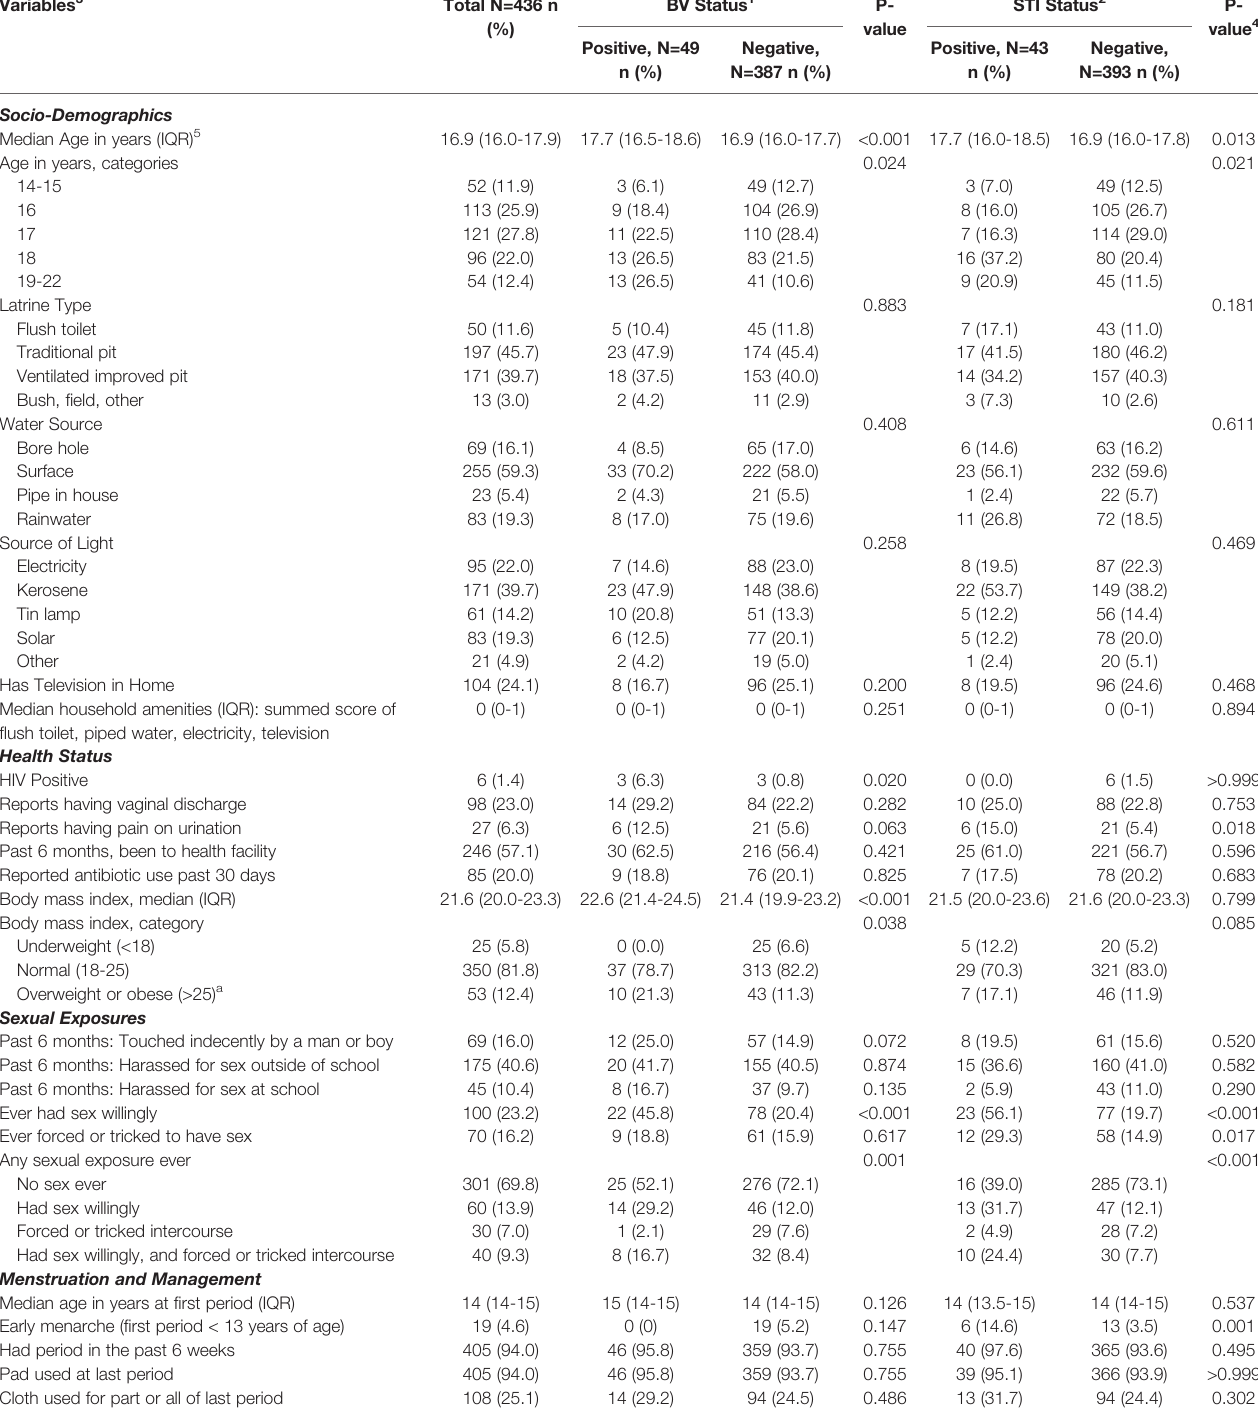
TABLE 1 | Distribution of baseline characteristics by bacterial vaginosis (BV) status and sexually transmitted infection (STI) status. Variables 3